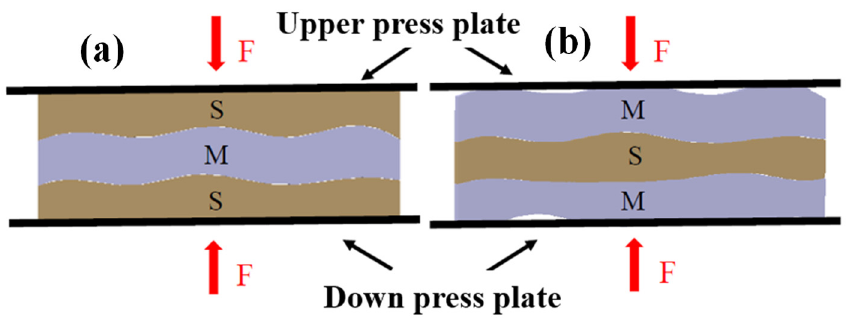
Figure 11. Stress state of the different laminated damping structures: ( a ) S-M-S laminated structure; ( b ) M-S-M laminated structure.